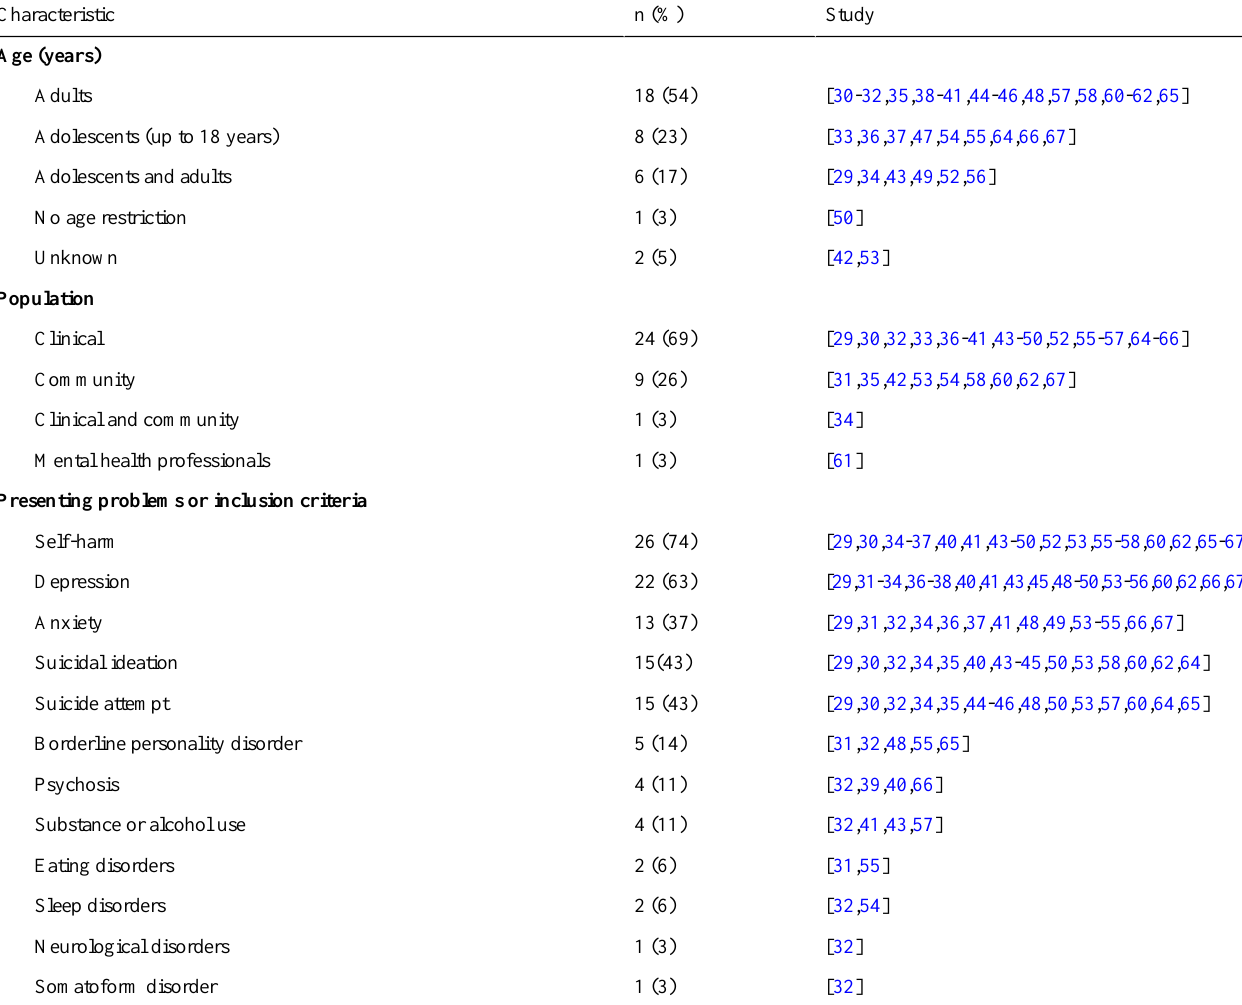
Table 2. Participant characteristics (n=35).